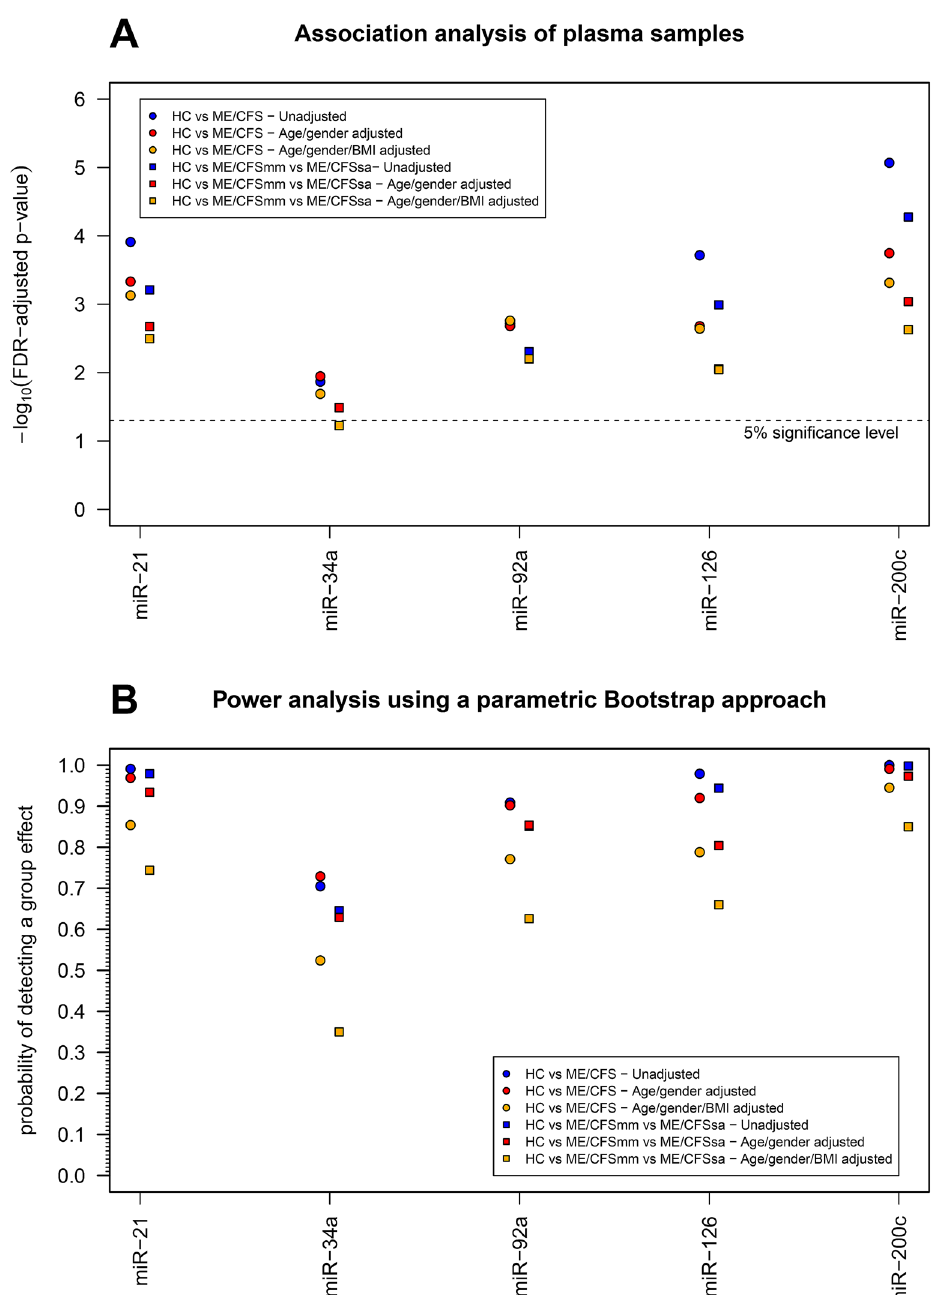
Figure 5. Association analysis between miR expression and study groups. ( A ) Association analysis adjusting for a global false discovery rate of 5% and controlling for age, gender, and BMI. Each dot represents the −log 10 ( p value) of a specific statistical association test while the dashed line represents −log 10 (0.05) above which it was consider a statistically significant association (i.e., −log 10 ( p value) > −log 10 (0.05)). P values were adjusted for a false discovery rate (FDR) of 5%. ( B ) Power analysis using a parametric Bootstrap approach under the assumption that the estimated models in A were the true ones for the data. In this analysis, the probability of detecting a group effect was estimated by the proportion of simulated data sets in which the group effect was statistically significant after adjusting for an FDR of 5%. The statistical analysis was performed in the R software version 4.0.2 (https:// www.r- proje ct.